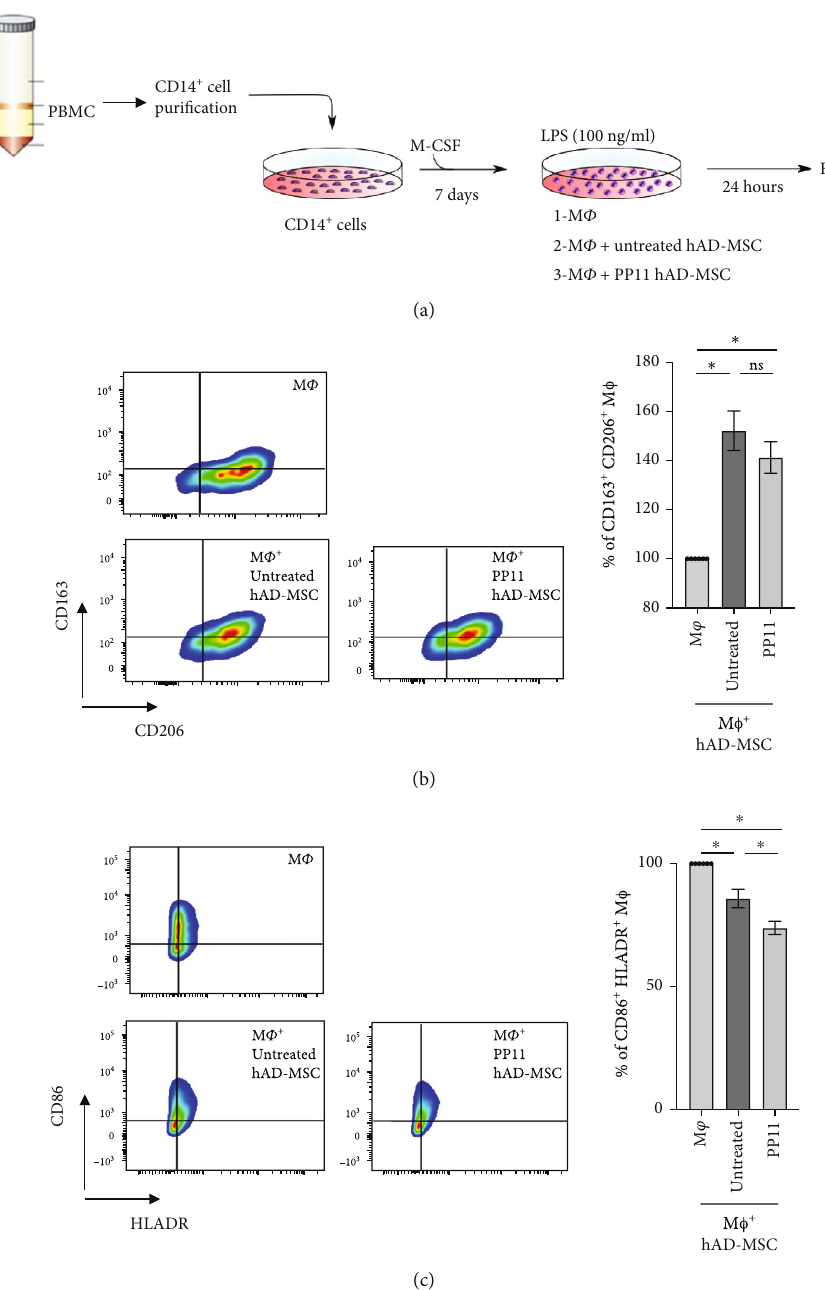
Figure 5: Role of the interaction between PPAR β / δ and NF - κ B TF65 subunit in hAD-MSC immunoregulatory property on macrophages. (a) Experimental design of human macrophage di ff erentiation and activation. CD14 + population was sorted from human PBMC using CD14 MicroBeads (Miltenyi) and cultured with 20ng/ml of M-CSF during 7 days. Then, the resulting macrophages were activated with 100ng/ml of lipopolysaccharides (LPS) and cultured alone (M ϕ ), naïve hAD-MSC (M ϕ + untretated hAD-MSC) or PP11-pretreated hAD-MSC (M ϕ +PP11 hAD-MSC) at ratio 1 :10 for 24 h. Cells were harvested to analyze macrophage phenotype by FACS. (b) Representative dot plots showing the M2-like macrophage population. Macrophages were analyzed for the expression pro fi le of M2 markers including CD163 and CD206 to determine the percentage of M2-like macrophages CD163 + CD206 + when LPS-activated macrophages were cultured alone (M ϕ ), in the presence of naïve hAD-MSC (M ϕ + untretated hAD-MSC) or hAD-MSC pretreated with PP11 peptide (M ϕ +PP11 hAD-MSC). (c) Representative dot plots showing the M1-like macrophage population. Macrophages were analyzed for the expression pro fi le of M1 markers including CD86 and HLADR to determine the percentage of M1-like macrophages CD86 + HLADR + . The statistical analysis was performed using the nonparametric Kruskal-Wallis followed by Dunn ’ s post hoc test for multiple comparisons. The data were obtained with hAD-MSC from 3 donors ( N = 3 ) on 2 independent experiments. Statistical signi fi cance was noted as ns for p > 0 : 05 and ∗ for p < 0 : 05